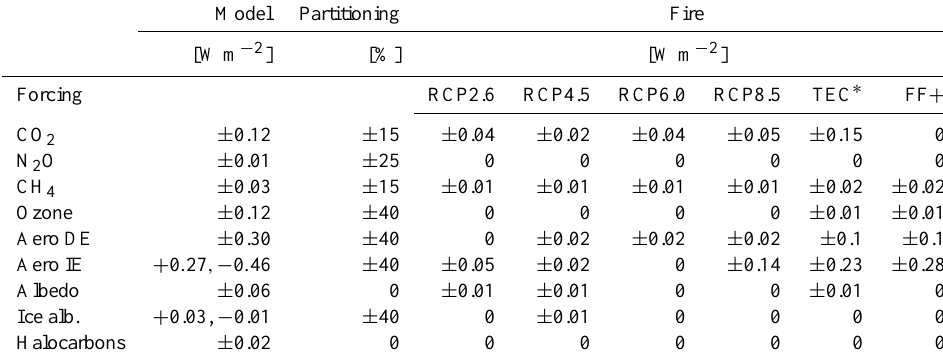
Table C1. Values for the three types of uncertainty calculated in this study. Uncertainty due to fires is specific to each future LULCC scenario and for other future anthropogenic activities (FF + )